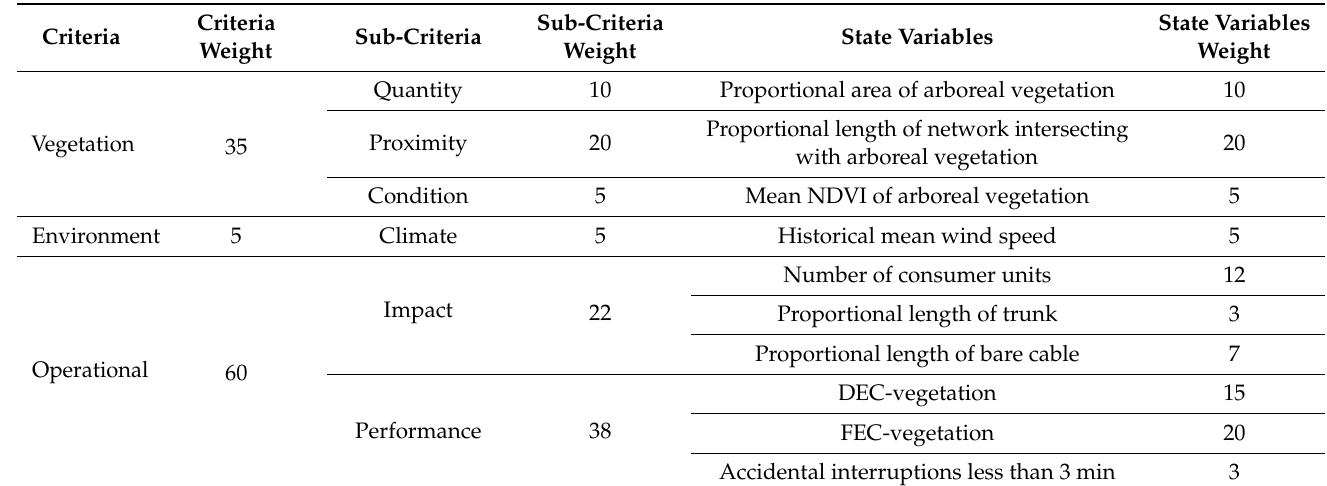
Table 5. Weights used to compute PIVM for urban